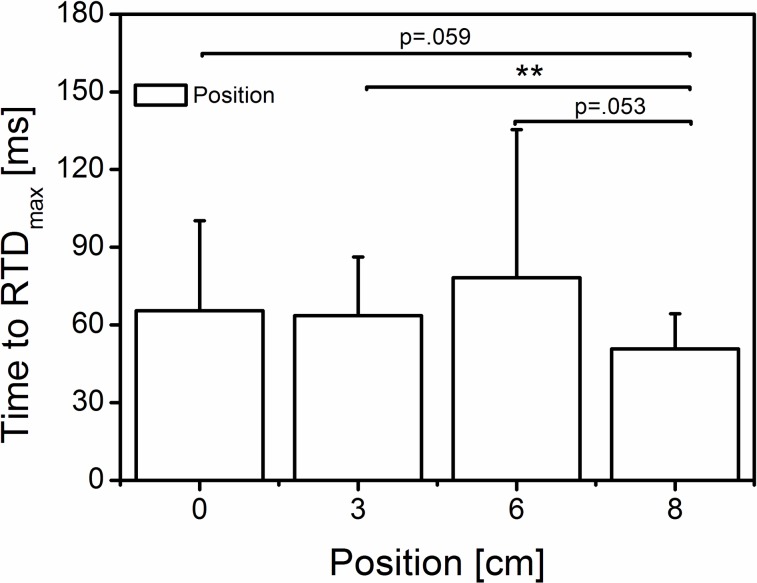
Time to reach the maximal rate of torque development.Mean (±SD) (65.5 ± 34.8, 63.6 ± 22.6, 78.2 ± 57.2, 50.7 ± 13.6 ms for the 0, 3, 6 and 8 cm position, respectively). Statistical analysis showed a significant main position effect (Wilk’s lambda = 0.563, F (3, 24) = 6.202, p = 0.003, η2 = 0.437) on time to reach maxRTD. The bars indicate a significant difference and tendency among the positions (0 cm = neutral, 3-6-8 cm; n = 27); **significant difference (p < 0.01).